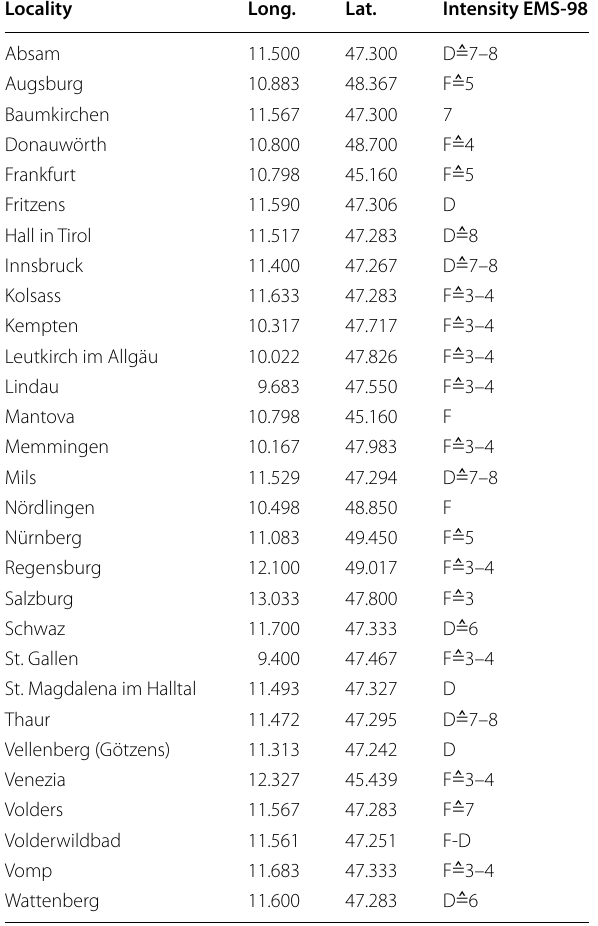
Table 2 Localities affected by the earthquake in